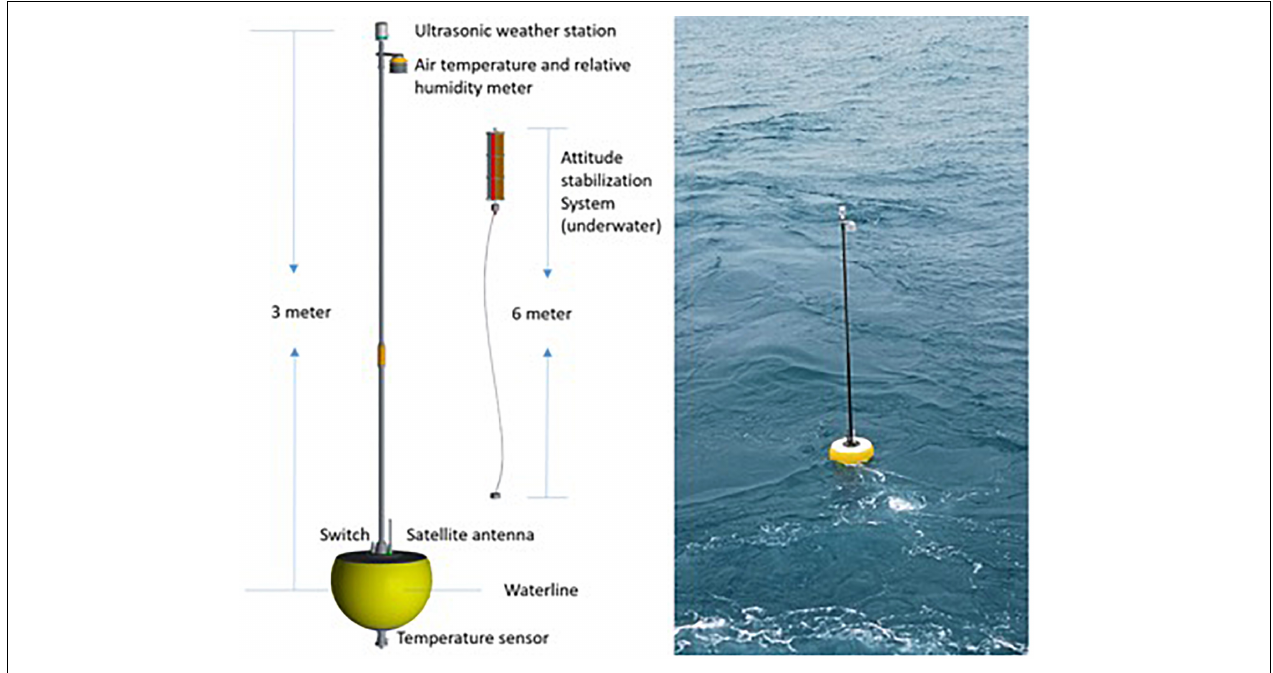
FIGURE 8 | Schematics and picture of the